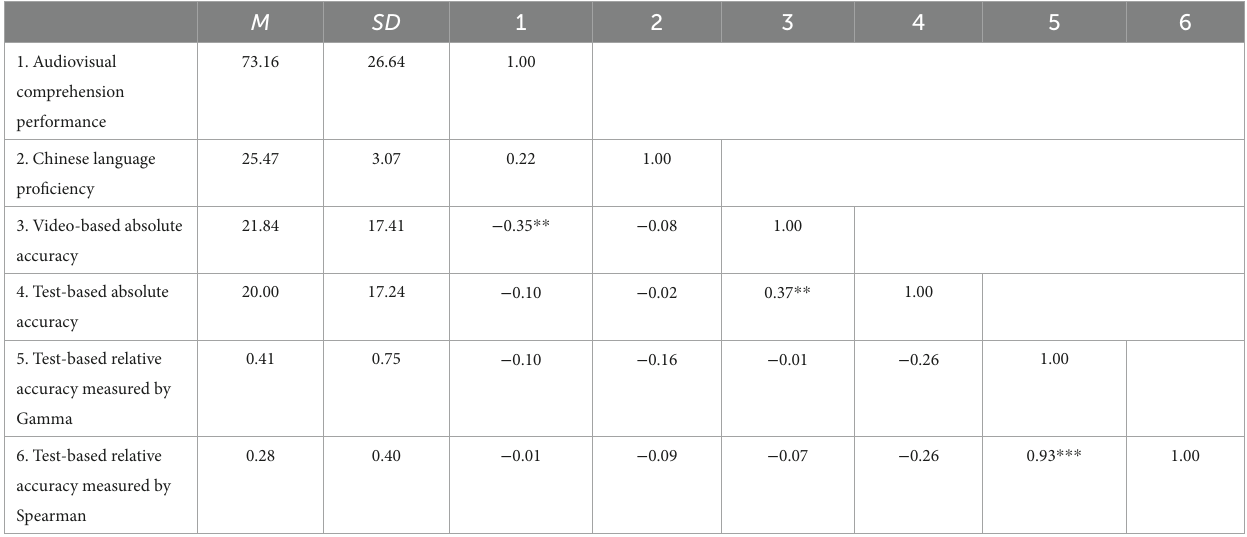
TABLE 1 Descriptive statistics and correlation matrix.